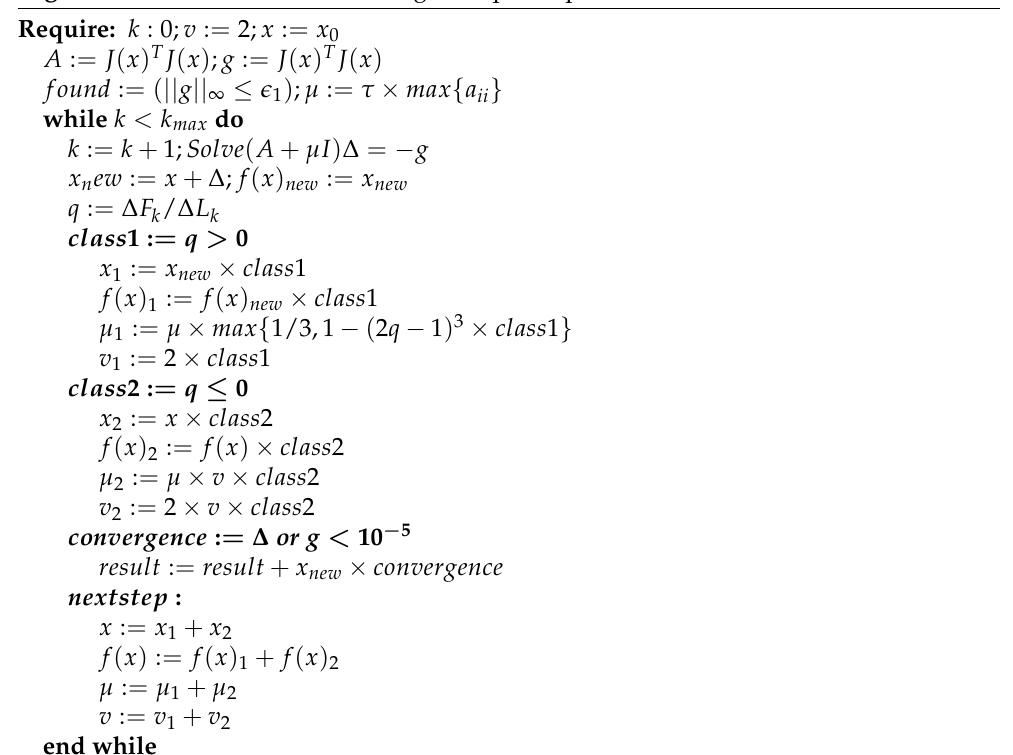
Algorithm A1 Flow of the Levenberg–Marquardt parallel